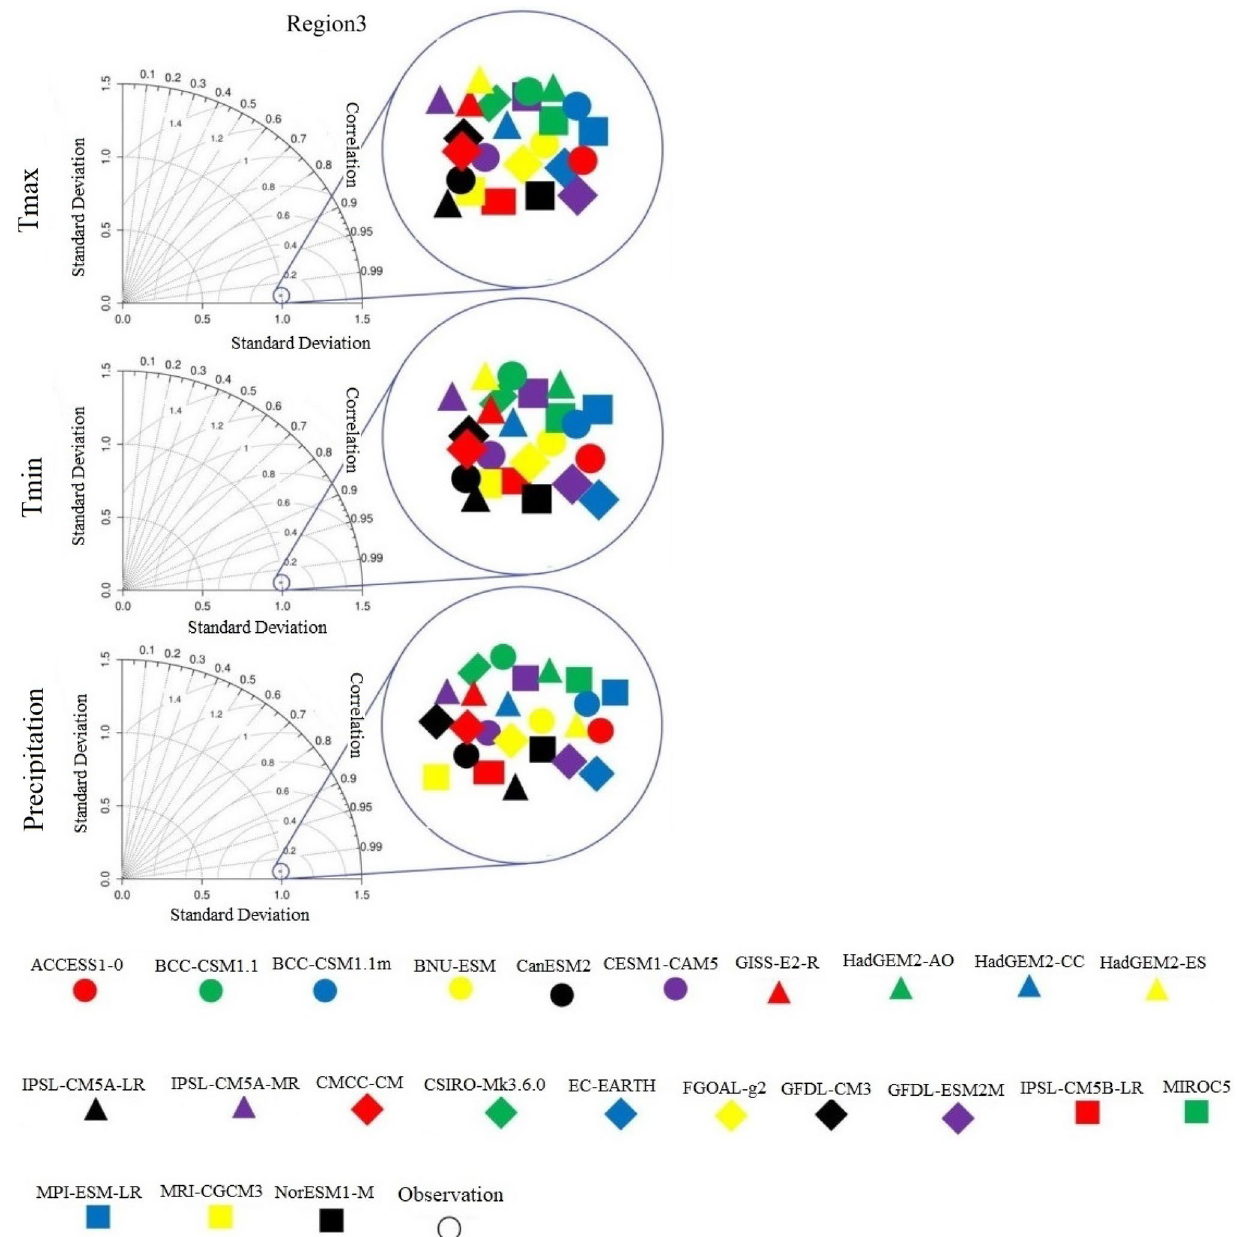
Fig. 15 Taylor diagrams for PCP, Tmax, and Tmin in region 3 in the baseline period